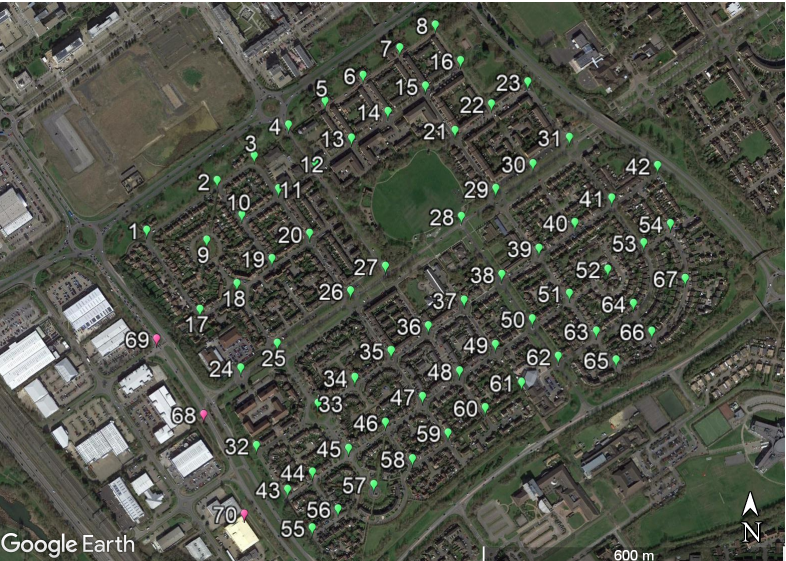
Figure 7. Oldbrook, Milton Keynes, United Kingdom (from Google Earth Pro). Green pins (1 ∼ 67) and red pins (67 ∼ 70) represents retail points and service points respectively.